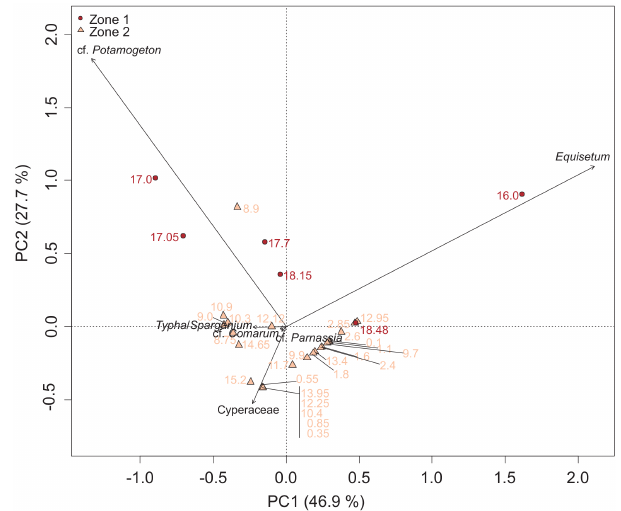
Figure 9. PCA biplot of swamp and aquatic taxa from pollen analy- sis. Sample depths (m) are coloured according to their correspond- ing zone. Explained variances of the two principal components (PC) are shown in brackets.